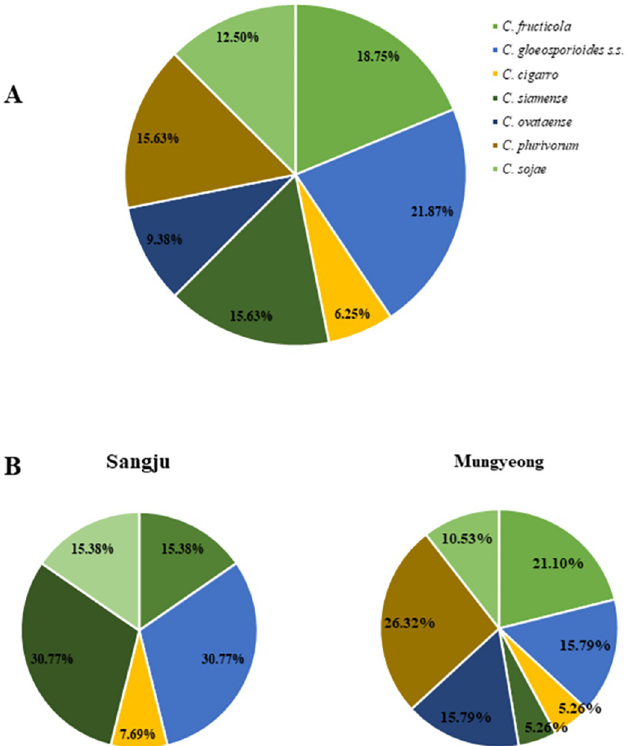
Fig 17. The prevalence of Colletotrichum species isolated from OLA. A: Overall isolation rate (%) of Colletotrichum species. B: isolation rate (%) of Colletotrichum species from each sampled area.